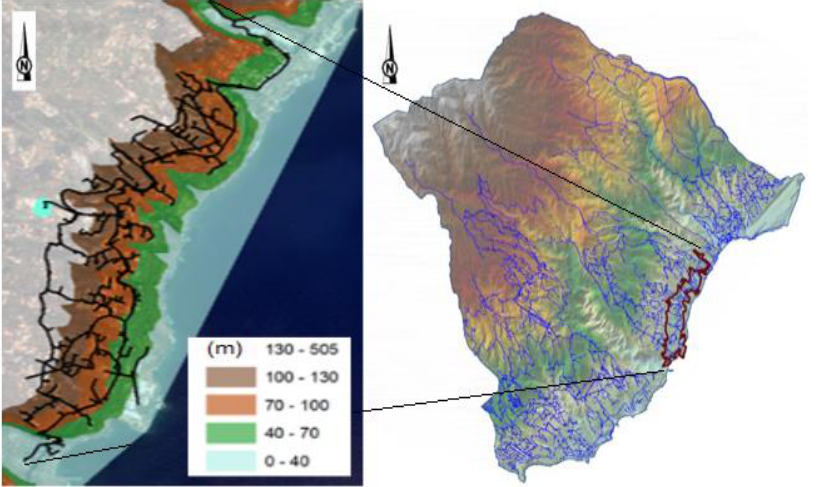
Figure 4. Location and topography of the Gaula network ( left ) and morphology of Madeira Island’s Santa Cruz municipality ( right ).